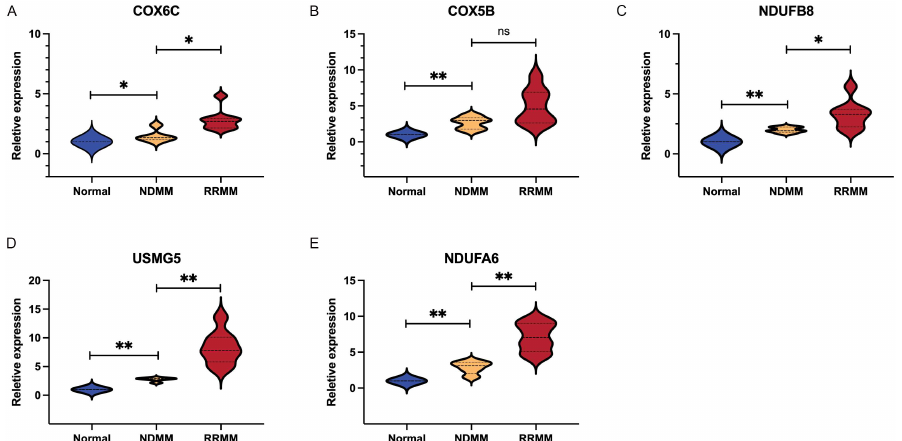
Figure 9. Validation of prognostic hub genes in clinical samples. ( A – E ). Relative expression of COX6C, COX5B, NDUFB8, USMG5, and USMG5 in different stages of MM patients.* p < 0.05, ** p < 0.01. COX5B, NDUFB8, USMG5, and USMG5 in different stages of MM patients.*